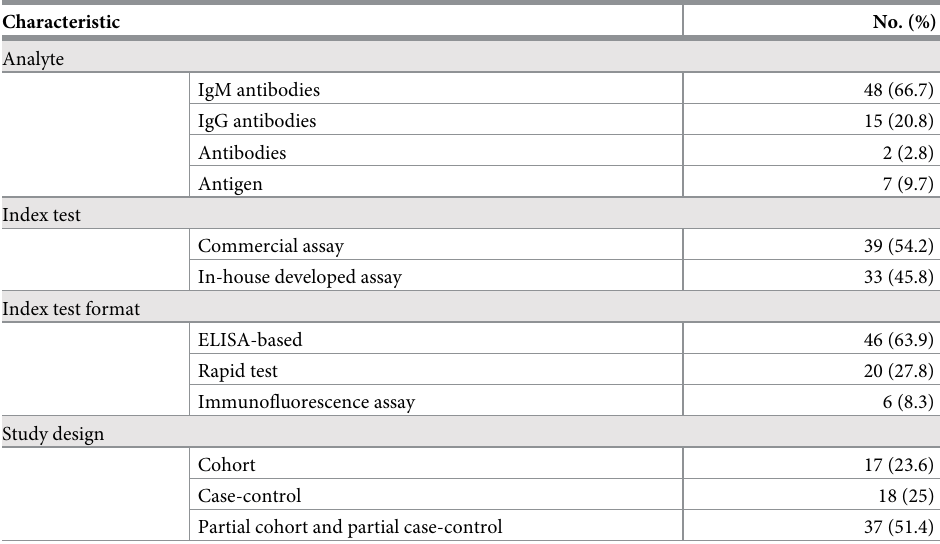
Table 5. Characteristics of the Index tests (n = 72) from the 35 included studies.